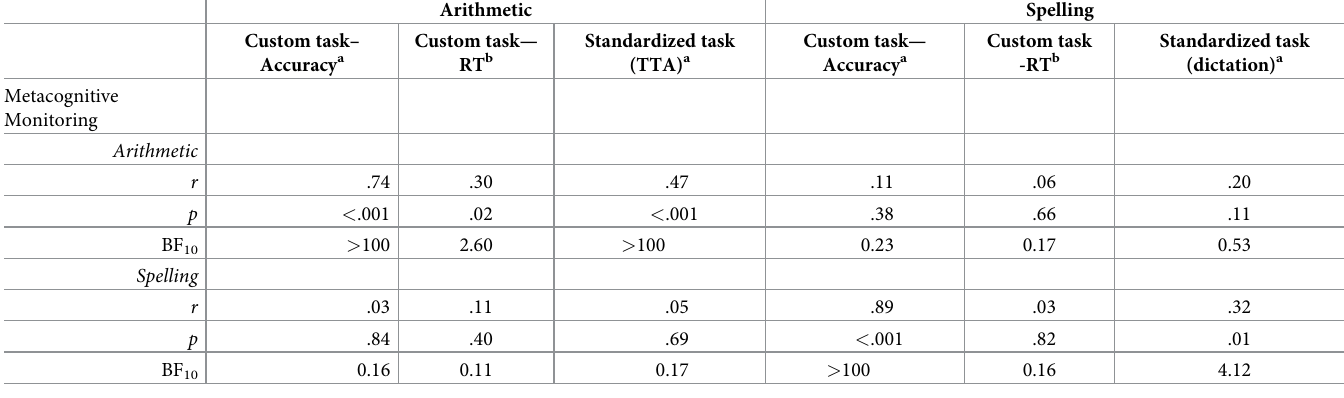
Table 4. Correlation analyses of metacognitive monitoring and academic performance measures in 7-8-year-olds (Grade